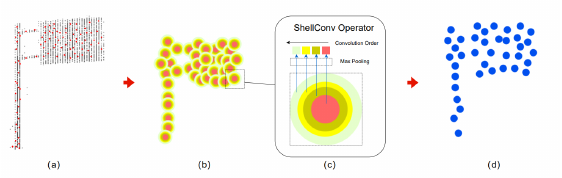
Figure 1. ShellConv. (a) The red dot is a random sampling point. (b) The set of points centered on the sampling point is distributed on the spherical shell. (c) The characteristics of these points are enhanced by maxpooling. (d) Output features.